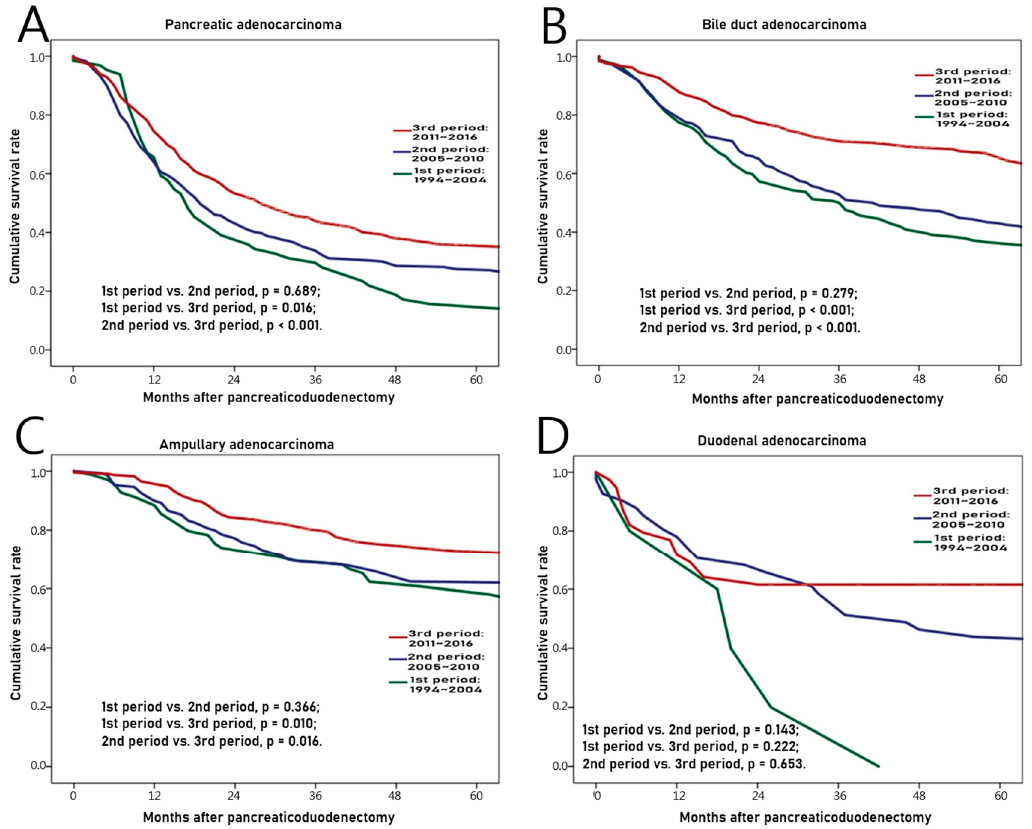
Figure 3. Chronologic differences of survival rates for those with each adenocarcinoma from 1994 to 2016. ( A ) Pancreas, ( B ) Bile duct, ( C ) Ampulla, ( D ) Duodenum.